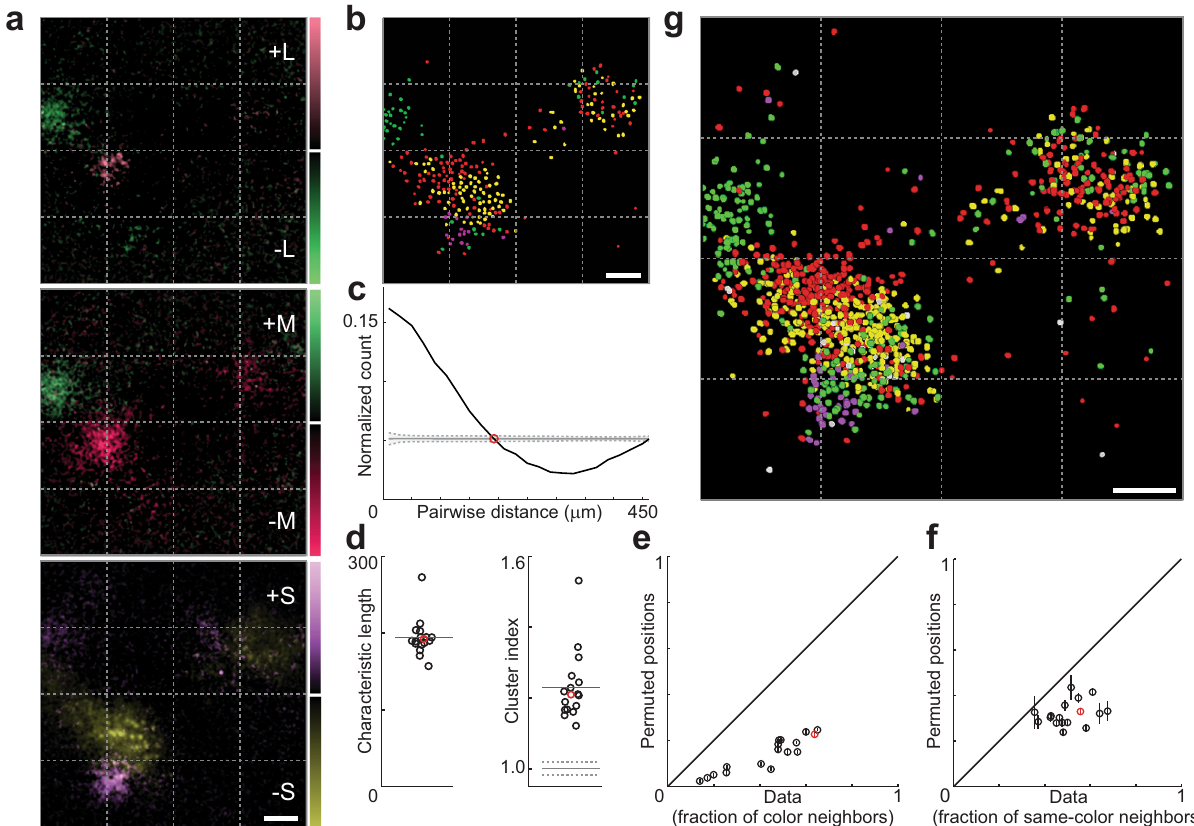
Fig. 2 Substructure of micromaps. a Δ F maps imaged at 230 μ m depth. b Cell-based map derived from a . c Fraction of all possible cell pairs that are both responsive, as a function of pairwise distance (black line; data from FOV in b ). Position-shuf fl ed control in gray, dotted lines ±1 SD across permutations ( n = 1000). Red circle marks characteristic length of observed data. Bin width, 20 µ m. d Characteristic lengths for 17 FOVs (left). Clustering indices for same FOVs (right); gray line, mean clustering index for position-shuf fl ed controls; dotted gray lines, ±1 SD ( n = 17,000). Red lines, data means. e Comparison of fraction of responsive cells within 40 µ m radius of responsive cells, for observed and permuted positions, same fi elds of view. f As e , except comparison of same-color neighbors. Error bars in e , f ± 1 SD across permutations ( n = 1000). Red markers in d – f represent fi eld of view in b . g Overlay of cell maps taken from fi ve different depths between 200 and 320 µ m (988 responsive cells out of 5221). Scale bars, 100 μ m (shared in a ). Source data are provided as a Source Data fi